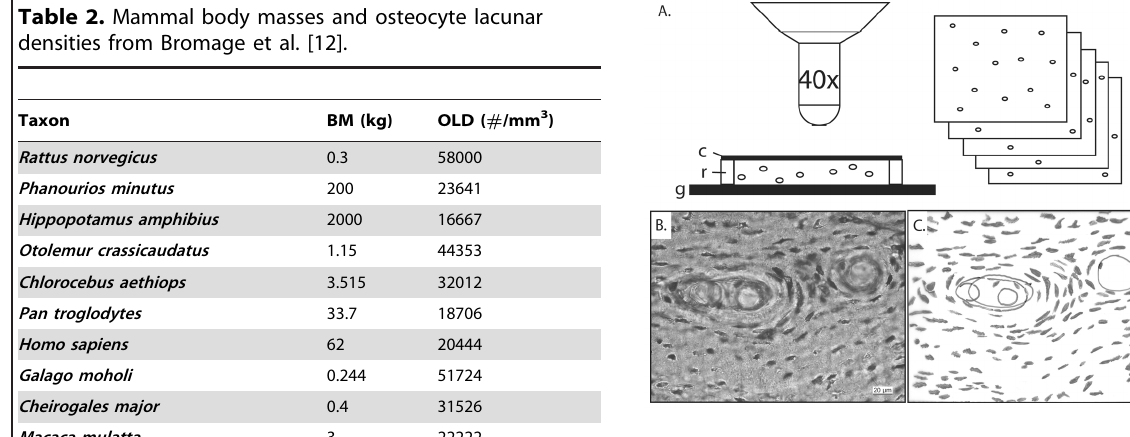
Figure 1. Method for acquiring z-stacks, and counting lacunae. A. Z-stack acquisition and thickness measurement. Thin sections were imaged at 40 6 magnification, the first image taken at the uppermost scratched surface of the specimen. The stage was then lowered with 5 m m for every subsequent image, until the lowermost scratched surface of the section was reached. Thickness of the sections was determined with a standard microscopic procedure. The sample was brought in focus on the upper surface of the epoxy resin. The stage was then lowered until the lower scratched surface of the epoxy resin was in focus. The difference in stage height setting, as read off the fine focus dial, was multiplied with the refractive index of the resin. This measurement was controlled with the number of images taken at 5 m m intervals. B , C , Lacunae identified in the z-stacks were projected on a two dimensional plane, and manually counted. The volume of bone was corrected for any vascular spaces, like in this example of Dicraeosaurus , any lacunae within the marked boundaries were ignored. The resulting volumetric density was then standardised to a volume of 1 mm 3 . Abbreviations : c , cover slip; g , glass slide; r , epoxy resin.